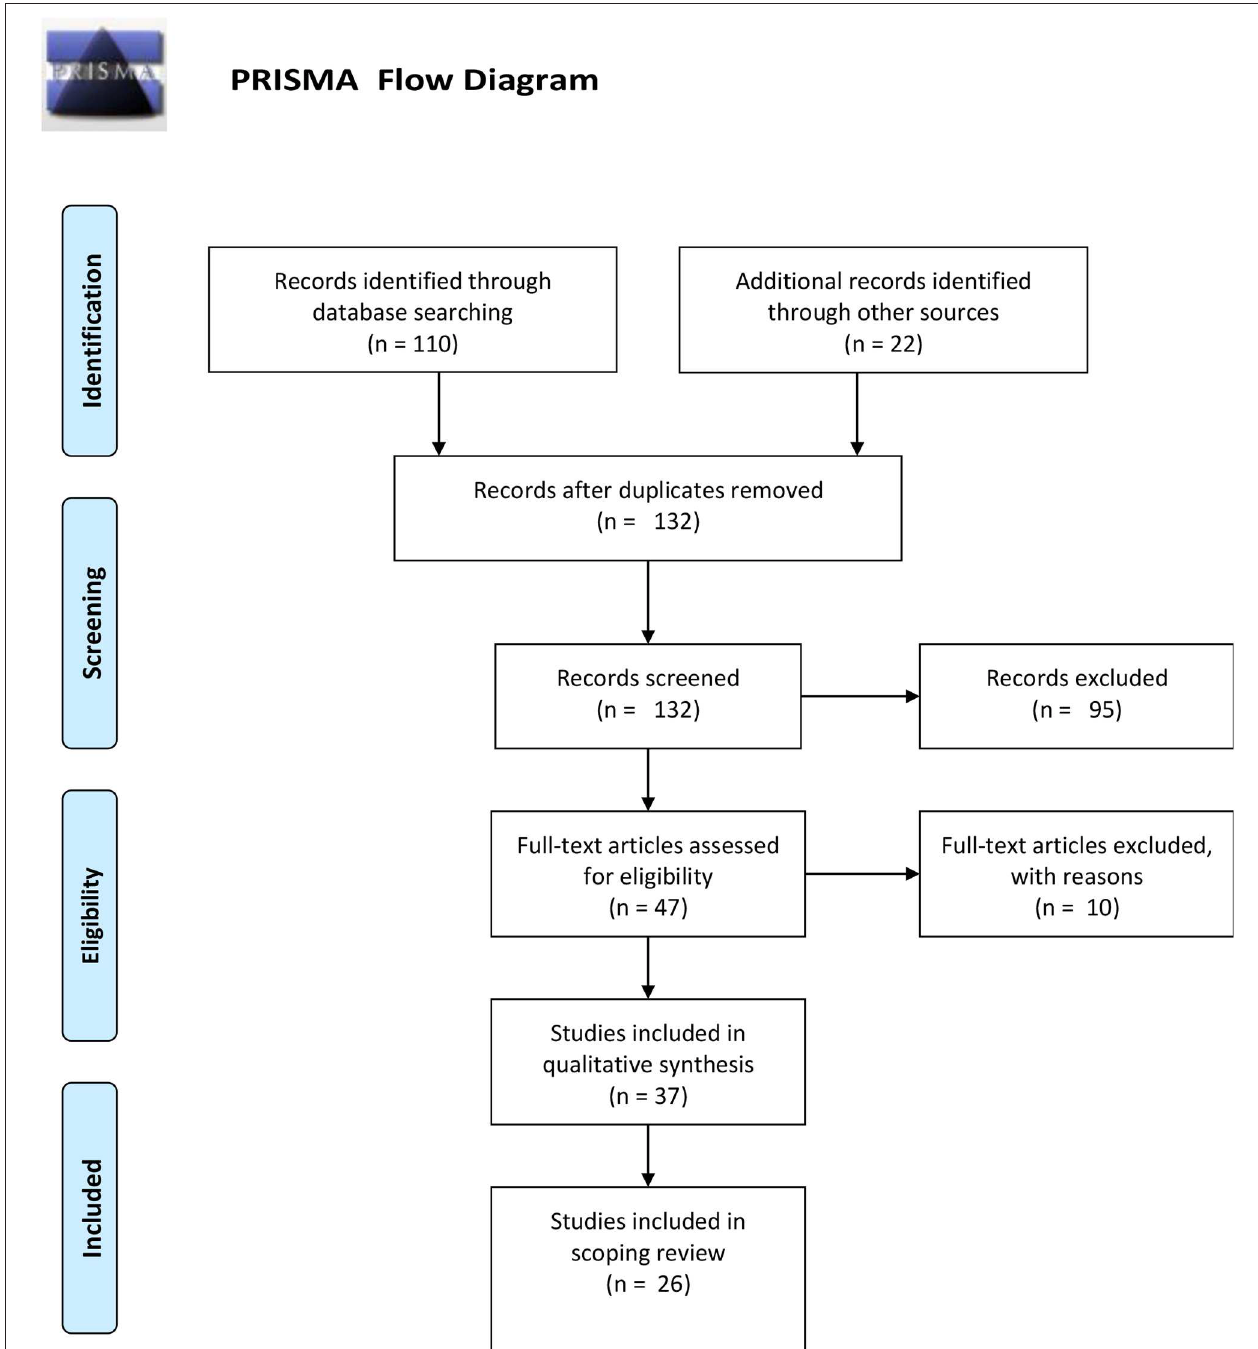
FIGURE 1 | PRISMA flow